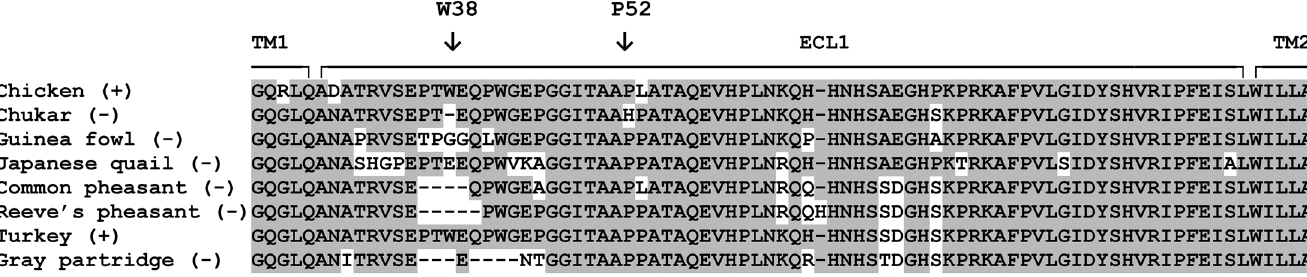
Table 2. Host range of new J subgroup RCAS vectors in avian species a . Species/Virus